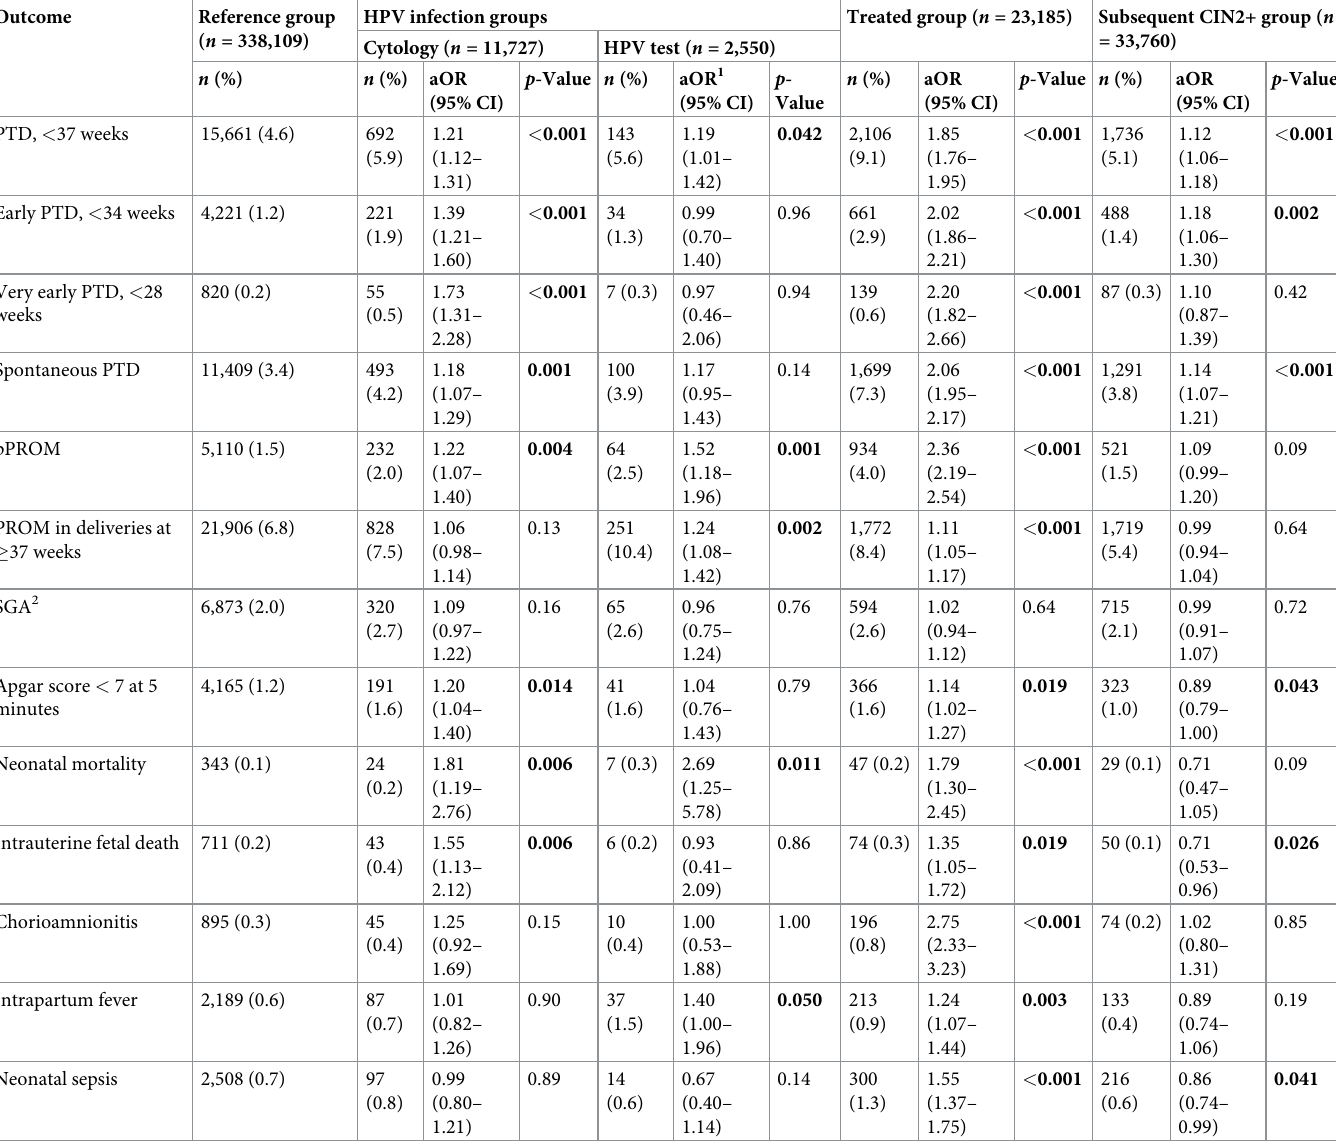
Table 2. Obstetric and neonatal outcomes in exposure groups compared to the reference group—adjusted multivariable logistic regression analyses.